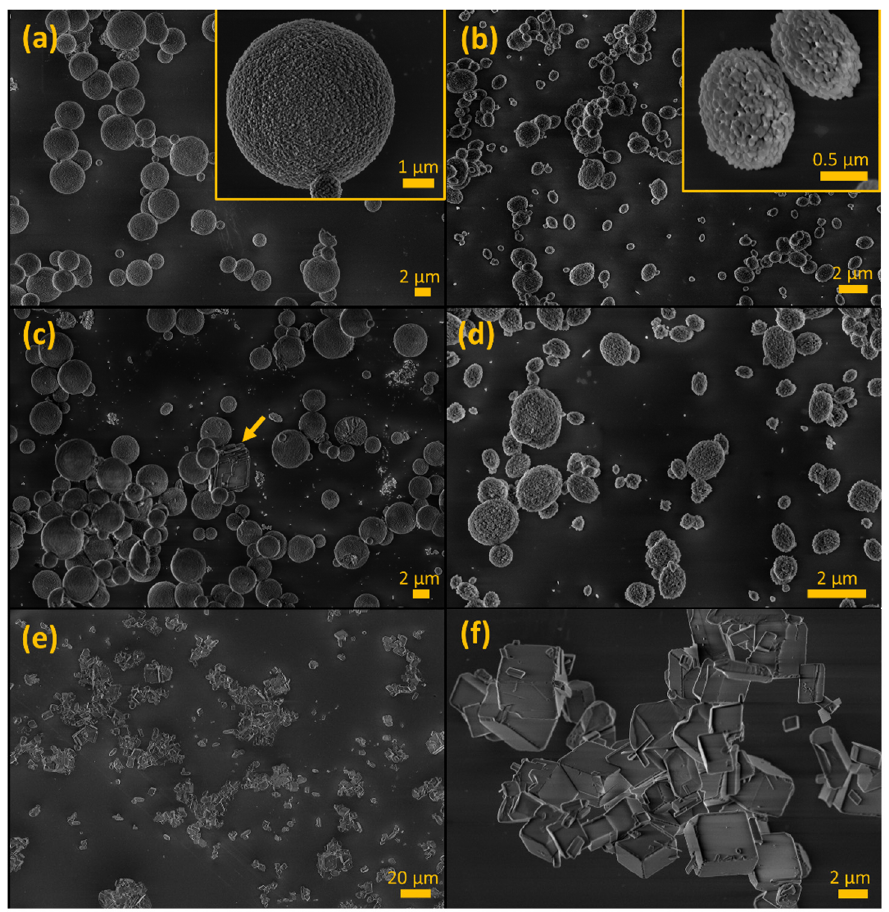
Figure 3. Scanning electron micrographs of various CaCO 3 particles. ( a ) First type of CaCO 3 microparticles (MPs), ( b ) smaller CaCO 3 microparticles (SMPs) produced in glycerol presence, ( c ) autoclaved CaCO 3 MPs with pamidronate (the arrow indicates a cuboidal particle), ( d ) autoclaved CaCO 3 SMPs with pamidronate, and ( e , f ) autoclaved CaCO 3 MPs with no additive.